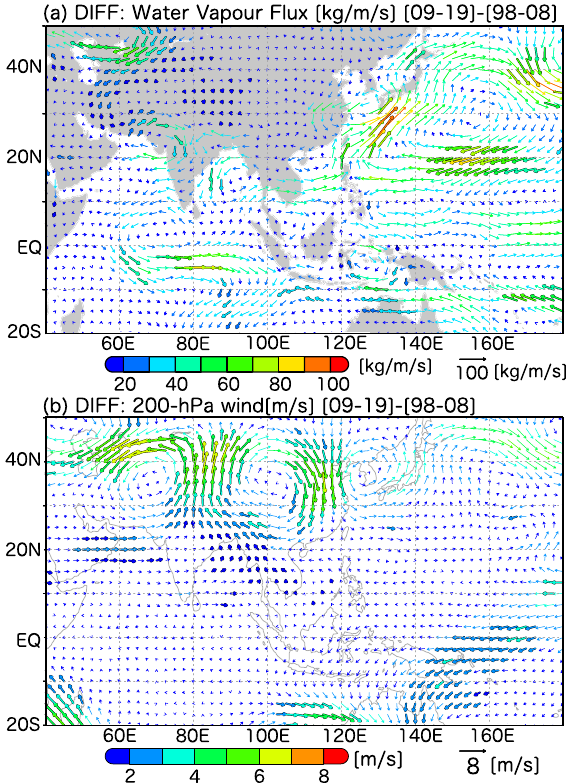
Figure 4. ( a ) Trends (22-year changes; differences between the two 11-year periods) in vertically-integrated water vapour fluxes from Earth’s surface to the top of the atmosphere during the Meiyu–Baiu season and ( b ) trends in 200-hPa winds. The statistical significances at a 95% confidence interval are shown by the black lines drawn around the edges of the vectors. Figure generated with GrADS 2.2.1 (http:// cola. gmu. edu/